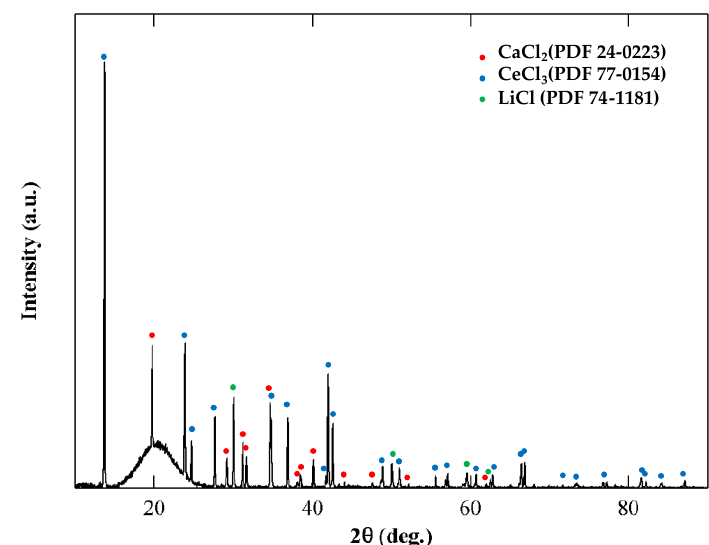
Figure 3. Powder XRD patterns of the CeCl 3 / 6 LiCl/CaCl 2 eutectic.